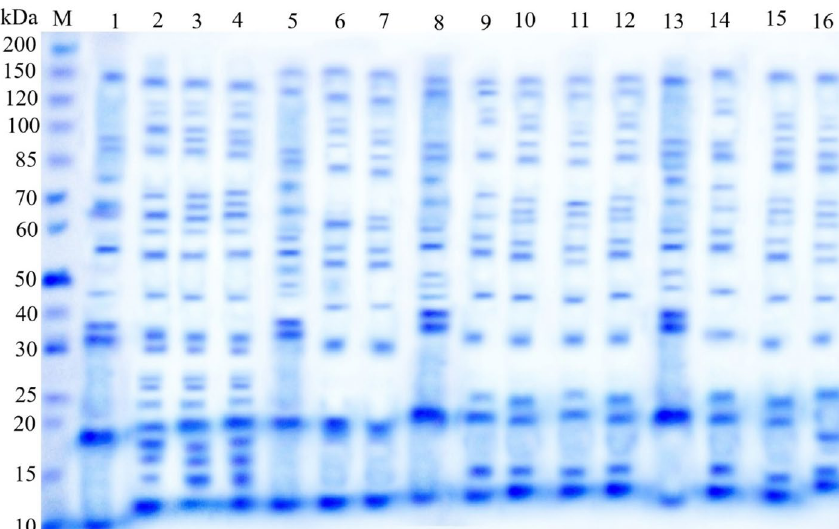
Fig. 1 SDS‑PAGE protein profile of 21‑day‑old pea seedlings treated with NaCl and SWEs ( S. vulgare , C. sinuosa , and P. pavonica ) single and combined treatments. kDa kilo Dalton; M marker protein; 1 = = extract; 6 S. vulgare extract 50 mM NaCl; 7 S. vulgare extract = + = 10 C. sinuosa extract 50 mM NaCl; 11 C. sinuosa extract = + = pavonica